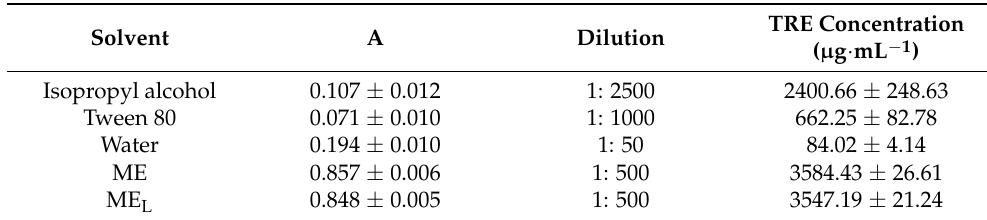
Table 2. Solubility of tretinoin (TRE) in hydrophilic components of the microemulsion or the mi- croemulsions themselves.